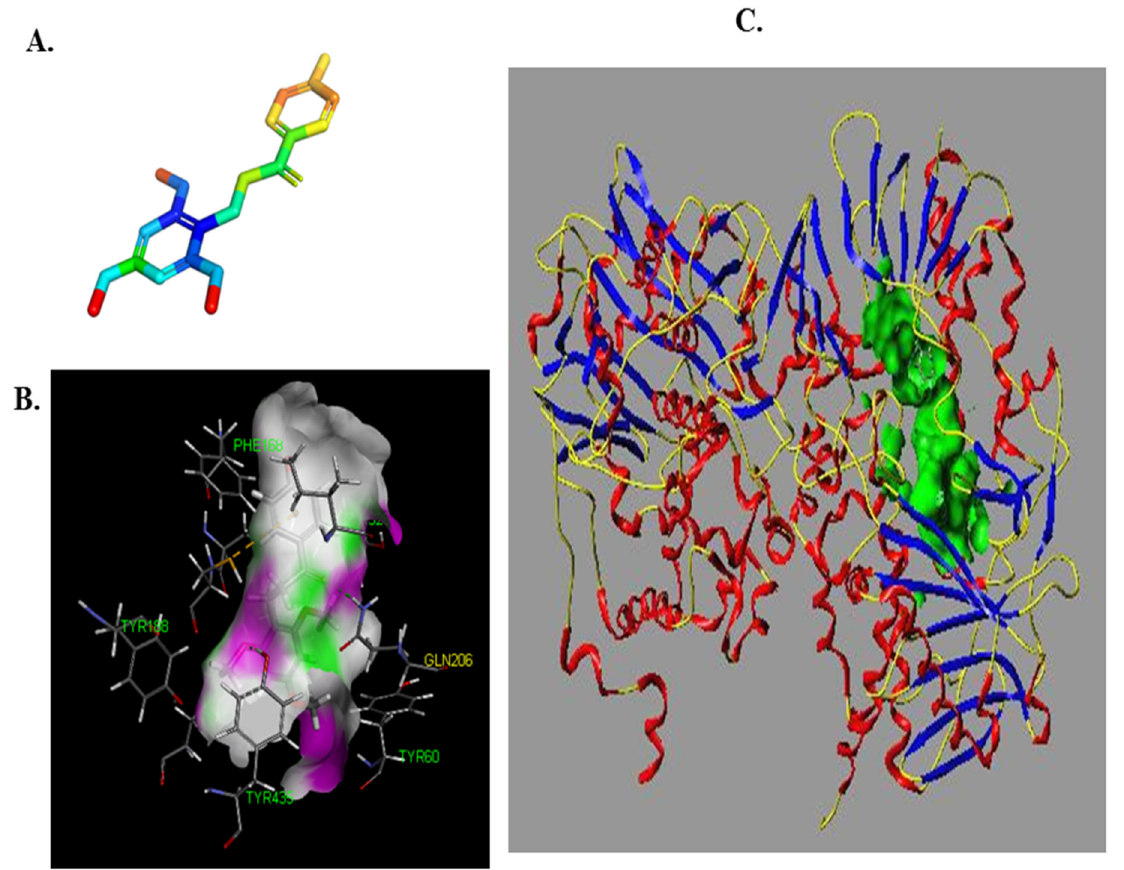
Figure 6. The docking results of LB with MAO-B and the binding pock of MAO-B. (( A ). The structure of LB, ( B ). The binding pocket of MAO-B, ( C ). The interaction of MAO-B and LB)